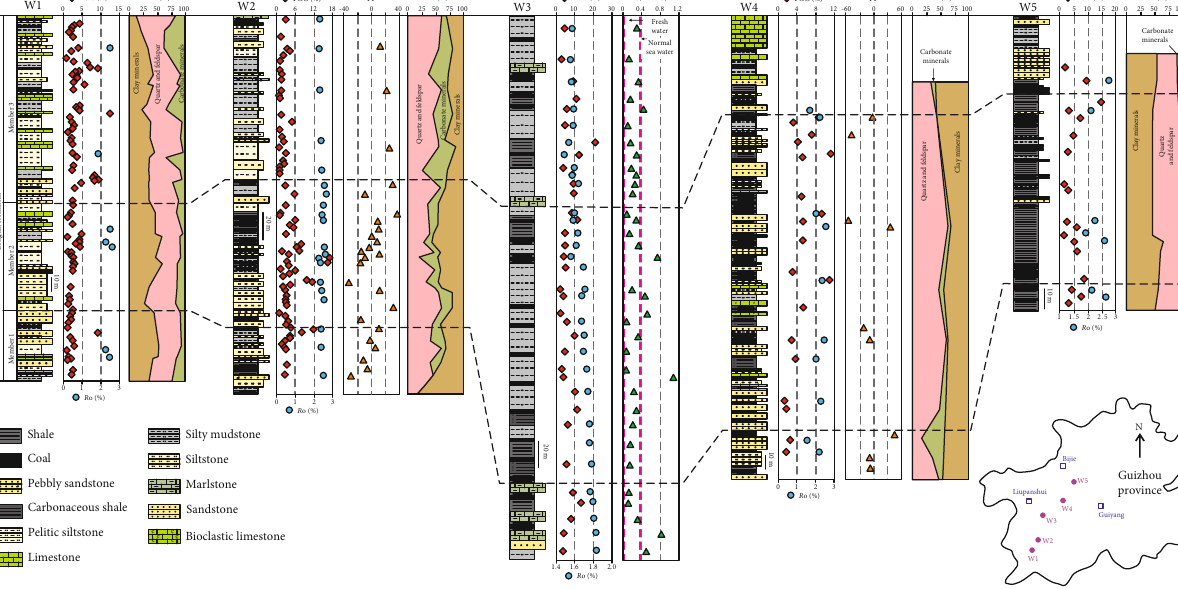
Figure 3: Organic geochemical characteristics and mineral composition of the Longtan coal series shale (the data of W1 is from [11, 12]; W3 is from [8]; W5 is from